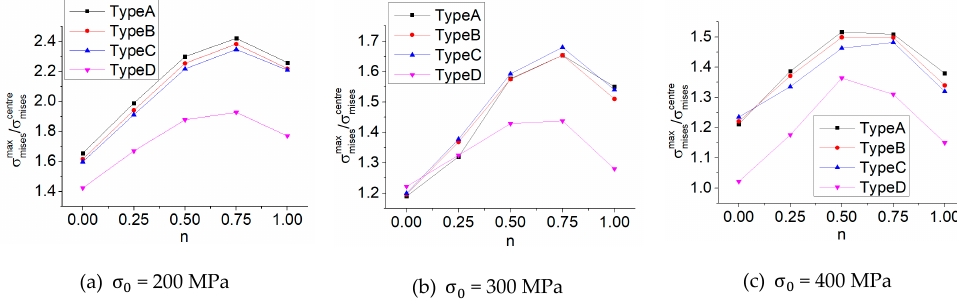
Figure 9. σ (cid:2923)(cid:2919)(cid:2929)(cid:2915)(cid:2929)(cid:2923)(cid:2911)(cid:2934) /σ (cid:2923)(cid:2919)(cid:2929)(cid:2915)(cid:2929)(cid:2913)(cid:2915)(cid:2924)(cid:2930)(cid:2928)(cid:2915) as a function of the n values under different applied stresses. Figure 9. σ max / σ centre as a function of the n values under di ff erent applied mises mises